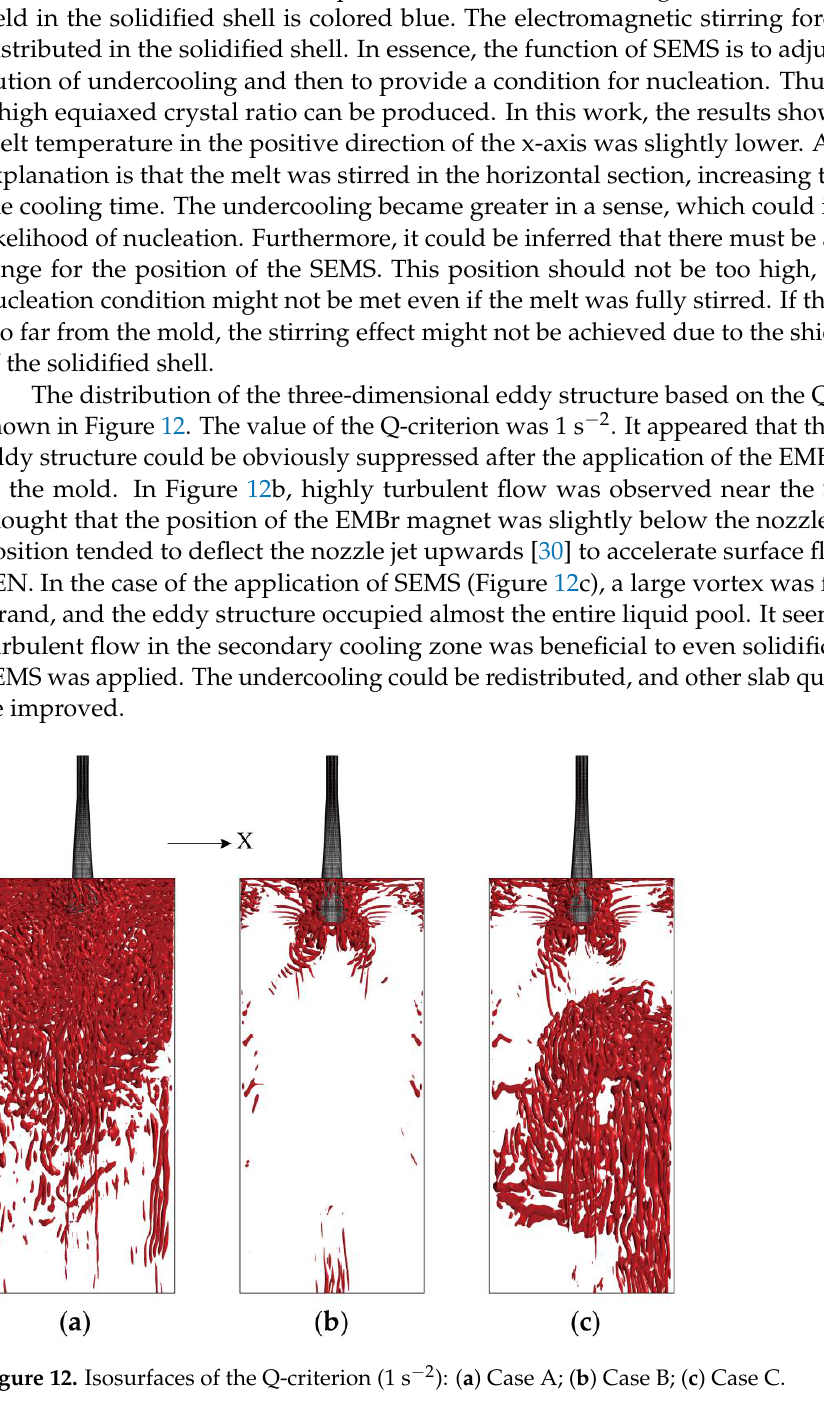
Figure 12. Isosurfaces of the Q-criterion (1 s − 2 ): ( a ) Case A; ( b ) Case B; ( c ) Case C.